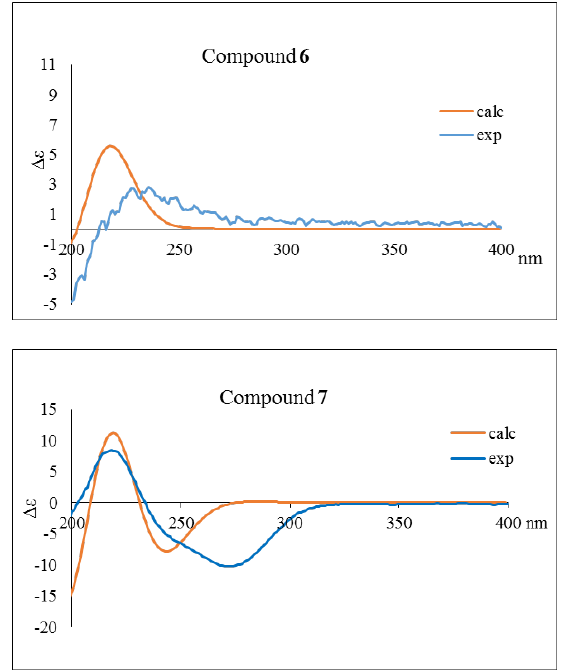
Figure 4. Experimental and calculated ECD spectra of compounds 6 and 7.